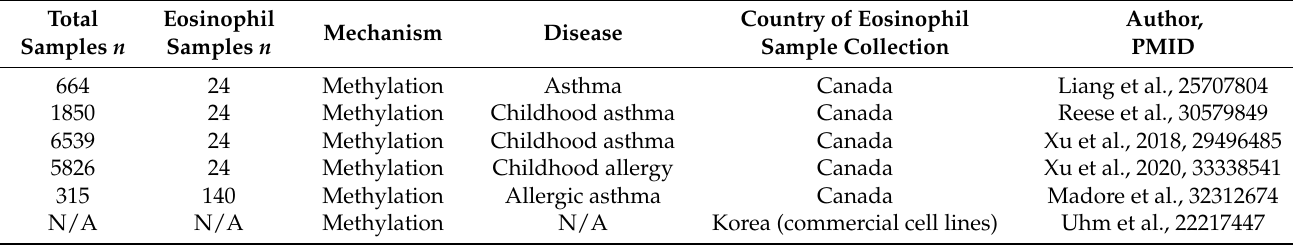
Table 2. Methylation studies of